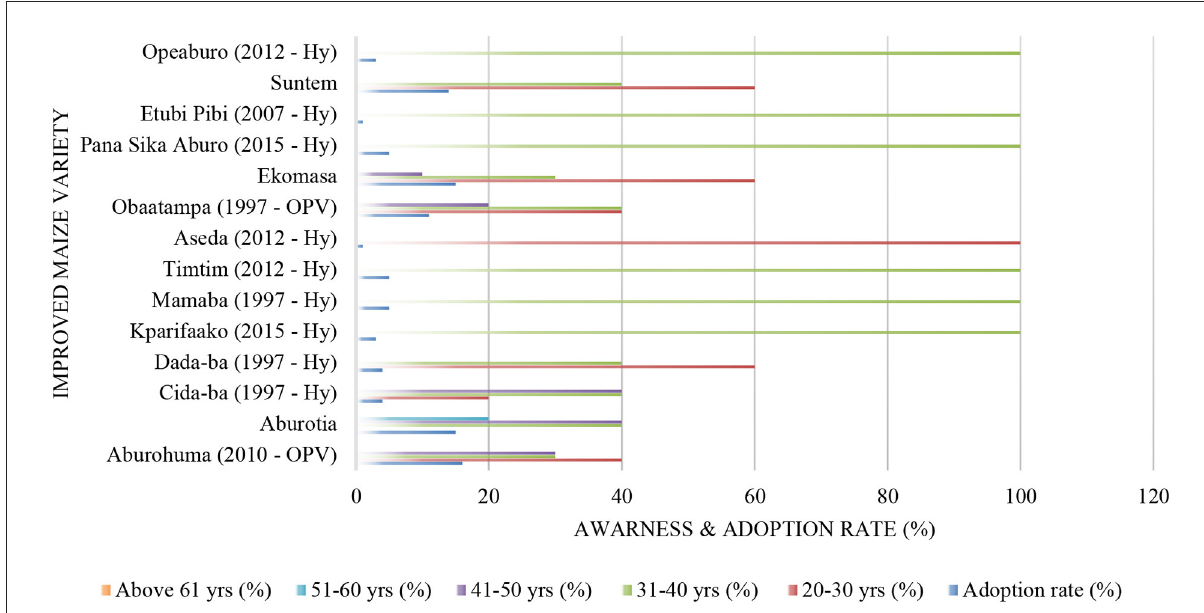
FIGURE5 Distribution showing improved maize variety and adoption rate per age group. Hy, Hybrid; OPV, Open Pollinated Varieties. Figure 6 compares the overall adoption rate of improved seeds with the adoption rate of respondents belonging to different age group categories. Author,